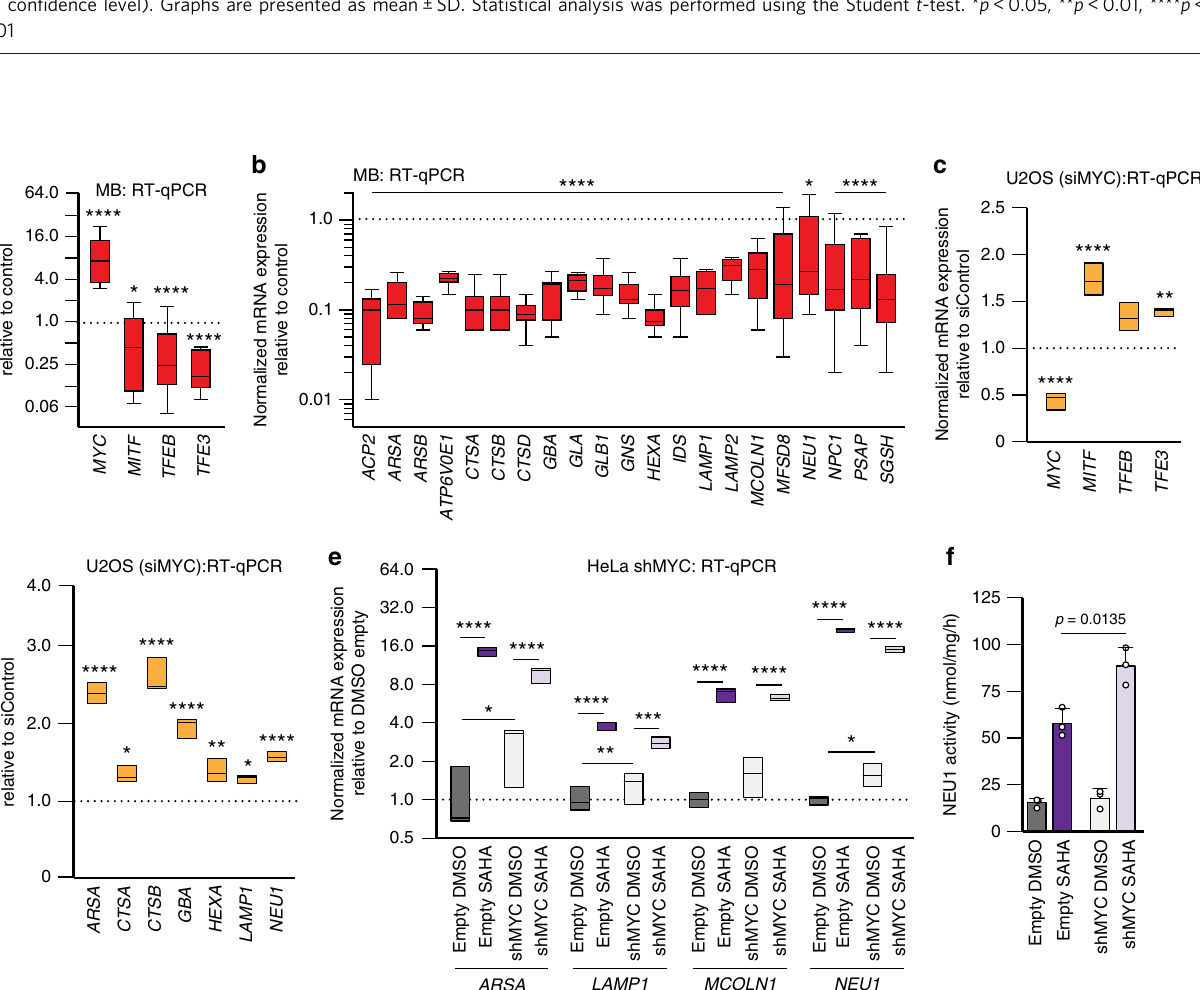
Fig. 3 MYC antagonizes MiT/TFE members. a , b RT-qPCR of MYC , MITF , TFEB , and TFE3 in ( a ) SAHA-treated (20 μ M for 24 h; n = 5 biologically independent samples) or b romidepsin-treated (10 nM for 24 h) HeLa cells ( n = 3 biologically independent samples) and compared to DMSO-treated cells. c ChIP analyses of NEU1 ( n = 3 biologically independent samples), LAMP1 ( n = 3 biologically independent samples), MCOLN1 ( n = 6 biologically independent samples), TFEB ( n = 3 biologically independent samples), and TFE3 ( n = 9 biologically independent samples) promoters using anti-TFEB antibody in HeLa cells treated with SAHA (20 μ M for 24 h) or DMSO. NEU1 INT oligos were used as negative control for non-speci fi c antibody binding